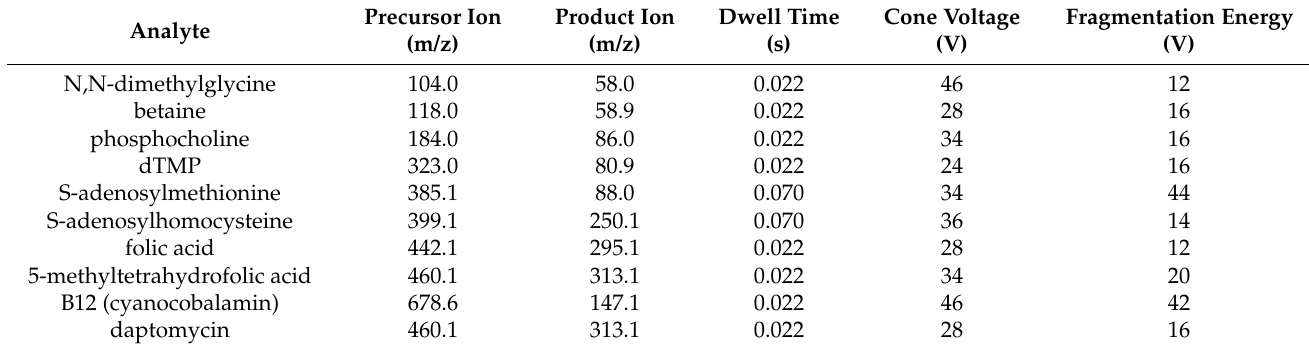
Table 3. Mass spectrometry parameters used in the